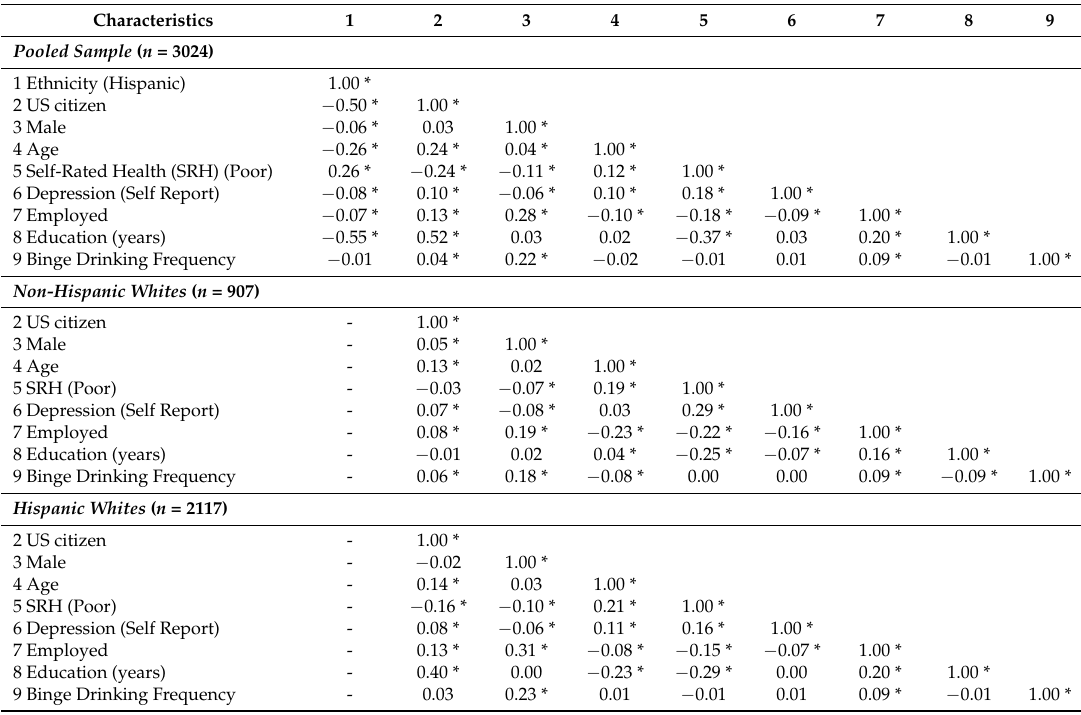
Table 2. Correlation matrix in the pooled sample and by